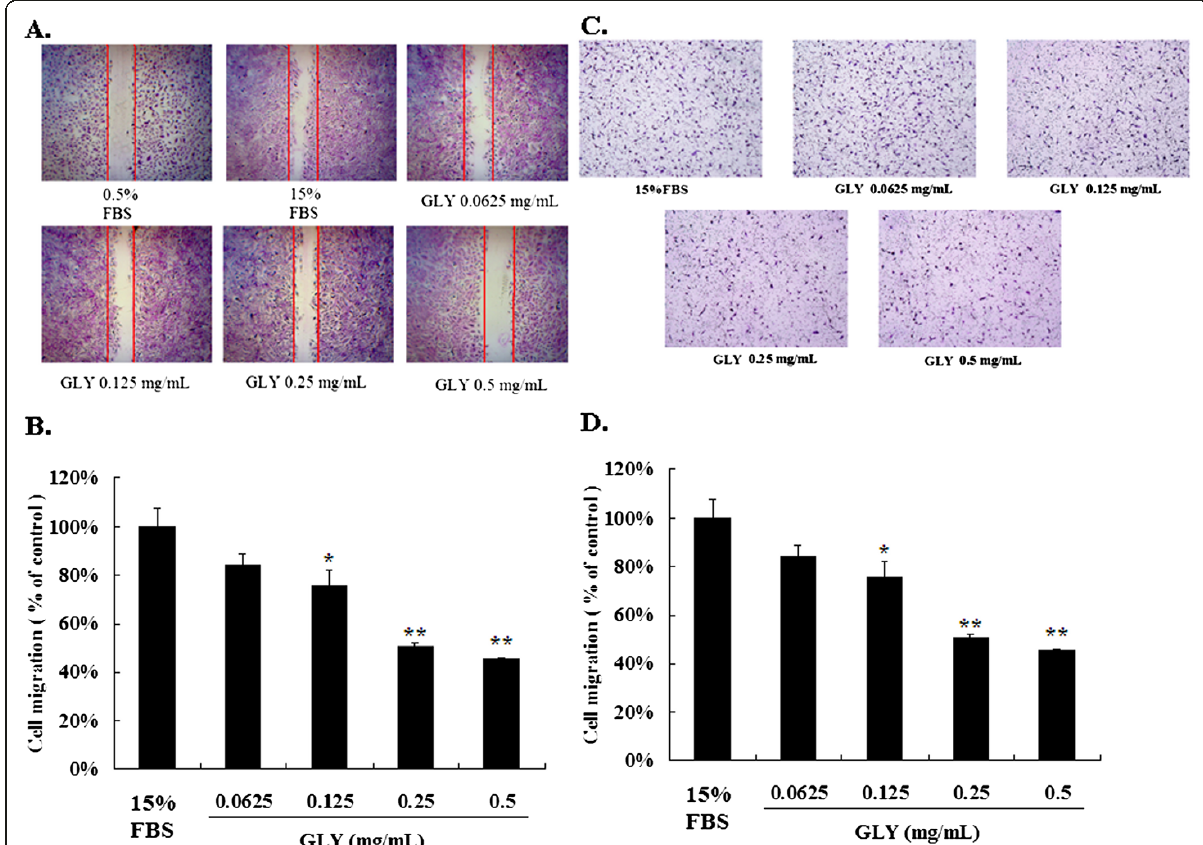
Figure 2 Effects of GLY on wound healing migration of VSMCs cells. Wound was introduced by scraping confluent cell layers with a pipet tip. VSMCs cells were incubated with GLY (0.0625, 0.125, 0.25 and 0.5 mg/mL) for 18 h, and the migration distances of cells were calculated. ( A ) Representative photographs of invading cells that received either control (15% FBS) or GLY treatment. ( B ) Migrated cells across the black lines were counted in six random fields from each treatment. The mean number of cells in the denuded zone is quantified by three independent experiments. ( C ). Effects of GLY on transwell migration assay vascular smooth muscle cells. VSMCs were incubated with GLY (0.0625, 0.125, 0.25 and 0.5 mg/mL) for 18 h, and ( D ). The transwell migration cells were calculated. Photos of the migration VSMCs cells were taken under a microscope (100-fold magnification). Mean value was significantly different from that of the control group (15% FBS): * p <0.05,** p